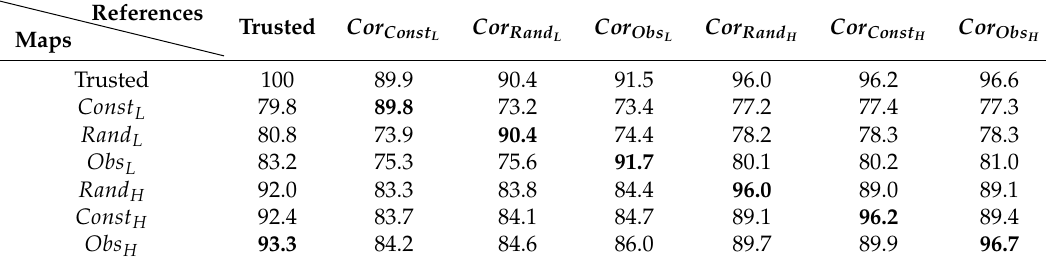
Table 2. Overall accuracies (OA) derived from the validation of synthetic maps with reference datasets correlated with the errors on the map. The first line refers to p ( j , k ) , the first column refers to p ( i , j ) and the other cells refer to p ( i , k ) . Maximum values for each type of imperfect reference dataset are in bold. The maps are sorted based on their OA with trusted reference. Const refers to constant errors on the off-diagonal cells, Rand refers to randomly selected errors, and Obs refers to errors rates that are based on a real case study. The letters L and H refer to low and high quality, respectively. For the reference datasets, 50% of the errors are copied from the corresponding classification indicated by the